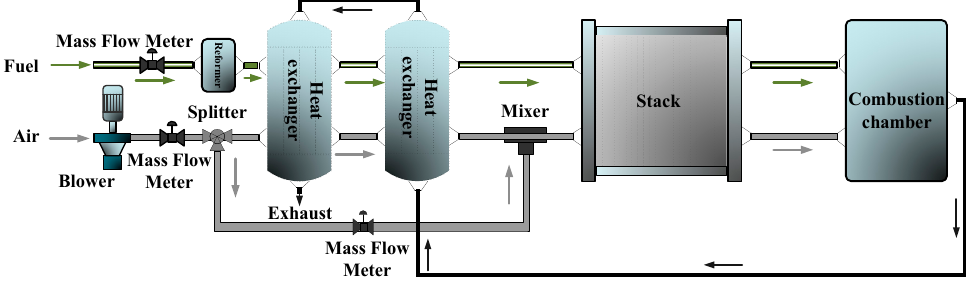
Figure 2. SOFC system structure.